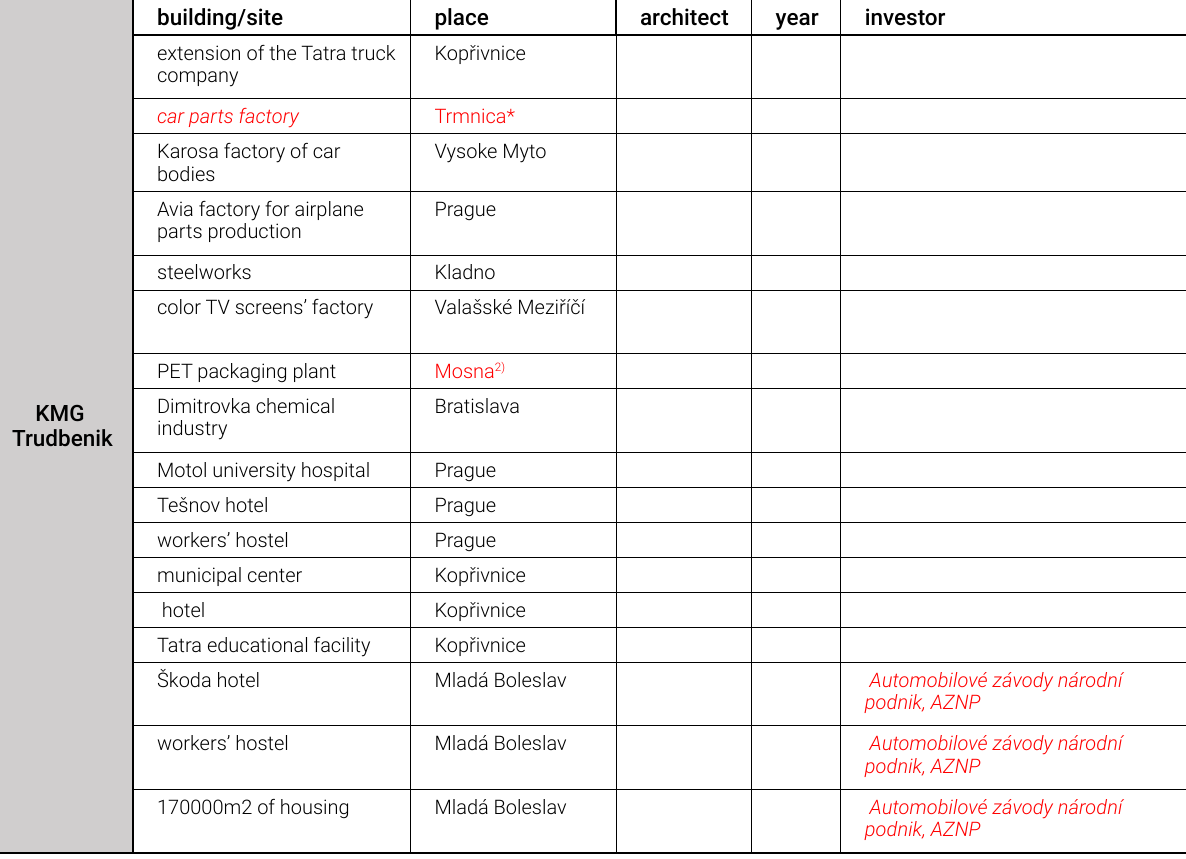
1) Monter, Zagreb, was a likely